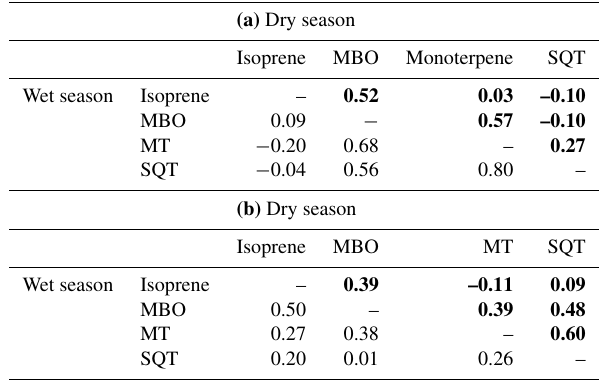
Table 4. Spearman’s correlation coefficients between the BVOCs during the wet and dry season of the first campaign (a) and second campaign (b)